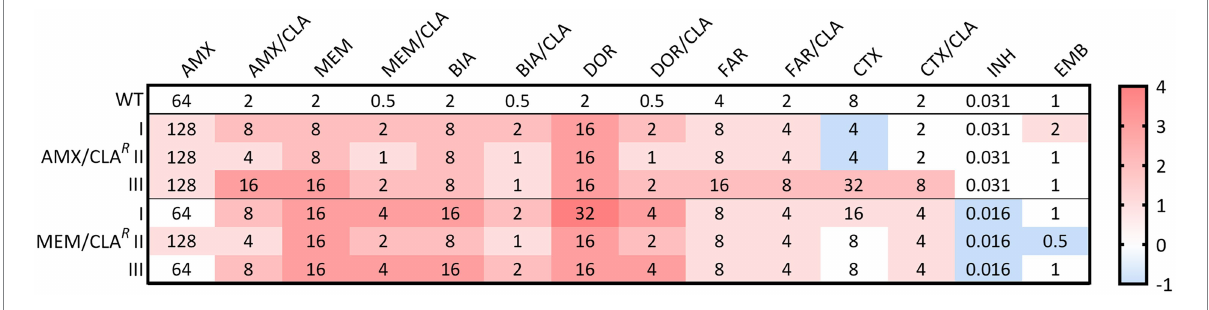
FIGURE 2 Heatmap of the log 2 fold changes in liquid medium minimum inhibitory concentrations (MICs) of the resistant Mtb H37Rv isolates. Columns represent the antibiotics and rows represent the isolates. The median MIC in mg/L of each antibiotic for each isolate is shown in the respective intersection and colors depict an increase (red/pink shades) or decrease (blue shades) in the value when compared to the wild type (WT) MICs. AMX, amoxicillin; BIA, biapenem, CLA, clavulanate; CTX, cefotaxime; DOR, doripenem; EMB, ethambutol; FAR, faropenem; INH, isoniazid; MEM, meropenem.